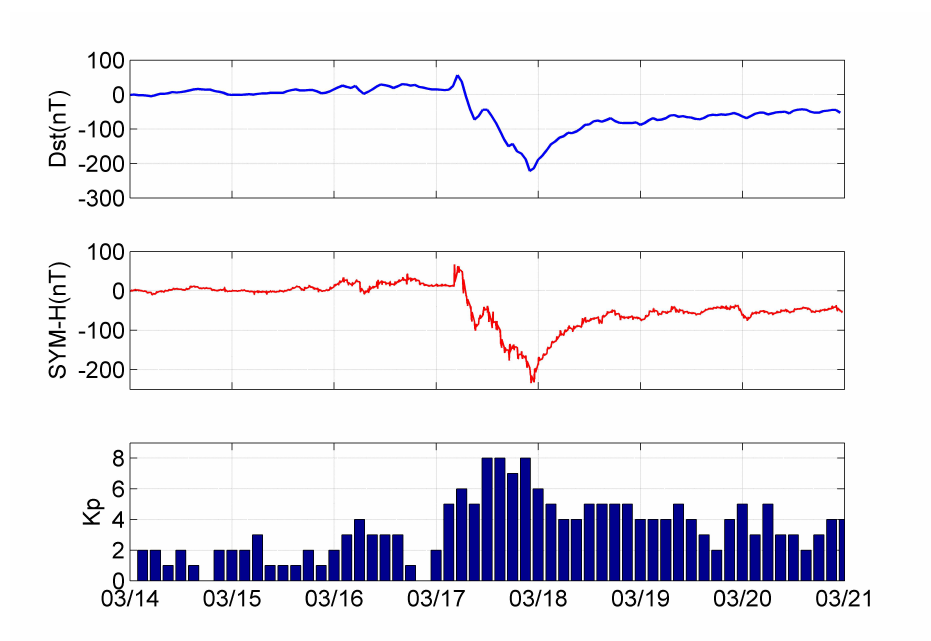
Figure 3. Variations of the geomagnetic parameters (Disturbance storm time (Dst), Kp, and SYM-H index) on 14–21 March